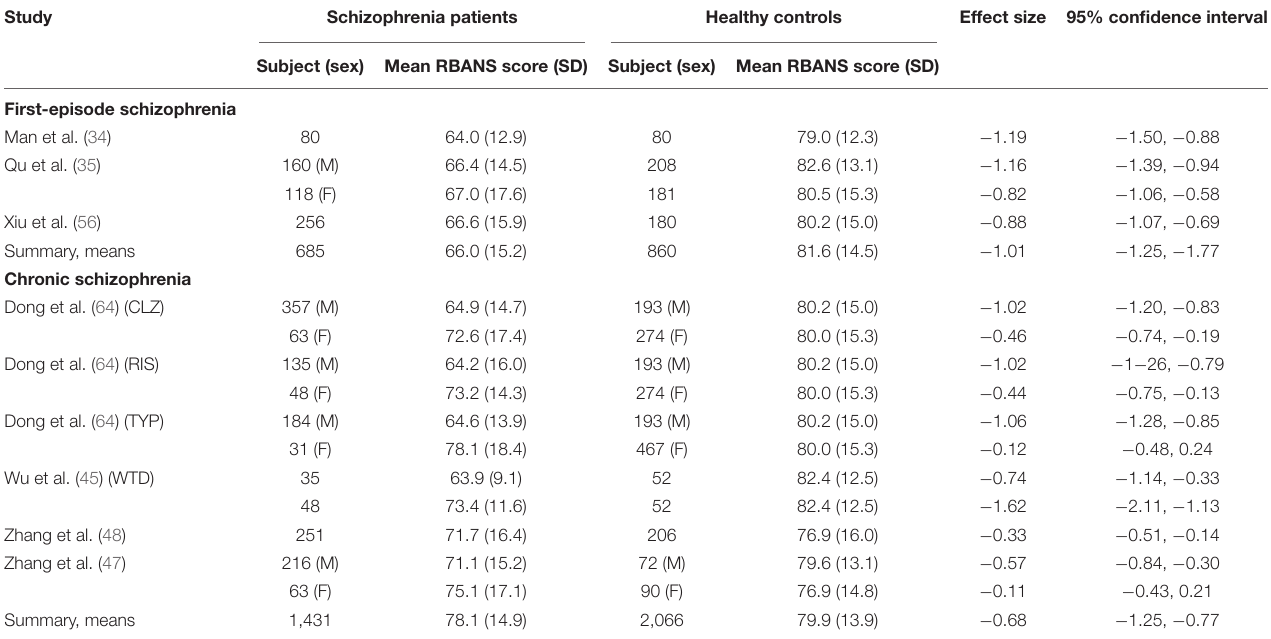
TABLE 2 | Baseline RBANS scores in first episode and chronic schizophrenia patients. Study